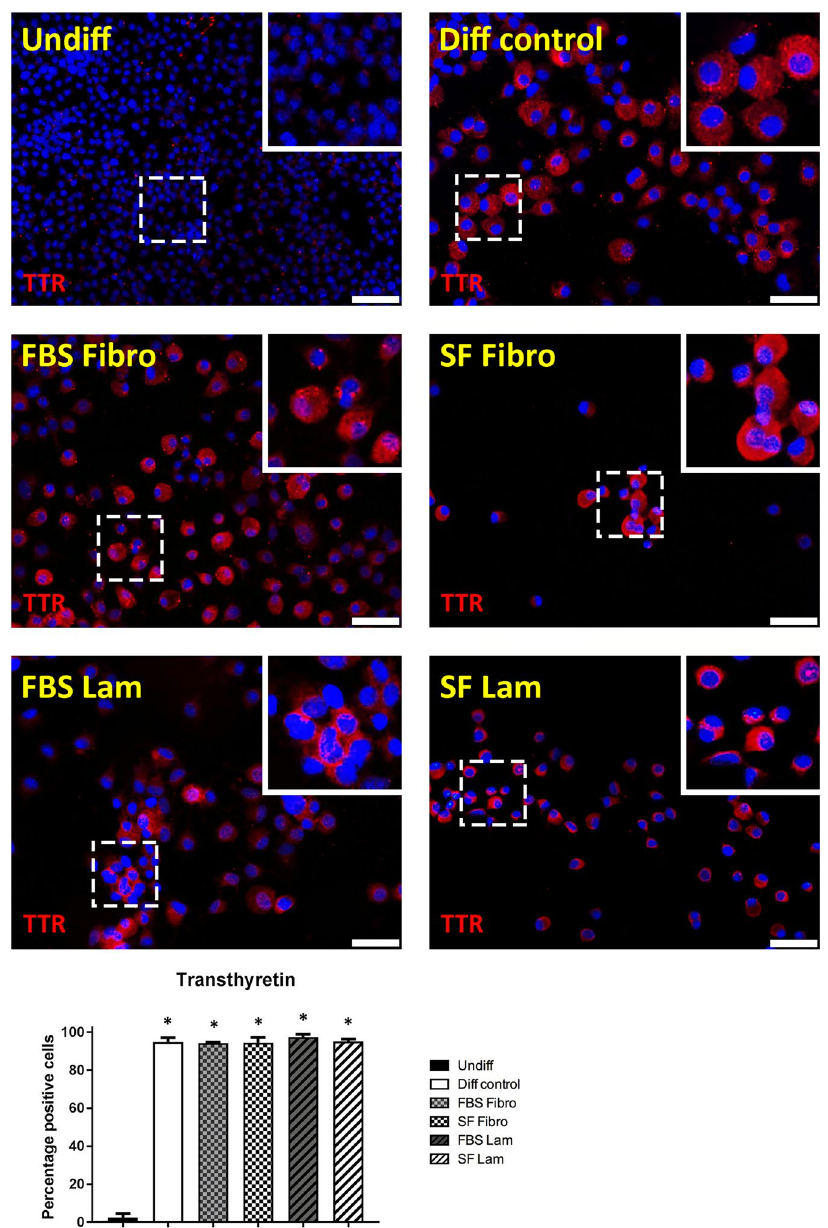
Figure 5. Immunofluorescent staining and quantification of the hepatocyte marker transthyretin (red) in undifferentiated AR42J-B13 cells and cells subjected to differentiation-inducing conditions on day 5, with DAPI (blue) for nuclear quantitation. Undiff - undifferentiated cells; Diff control - differentiation control, with FBS, on plastic; FBS Fibro - differentiation medium, with FBS, on fibronectin; SF Fibro - differentiation medium, serum- free, on fibronectin; FBS Lam - differentiation medium, with FBS, on laminin; SF Lam - differentiation medium, serum-free, on laminin. Scale bar = 50 µ